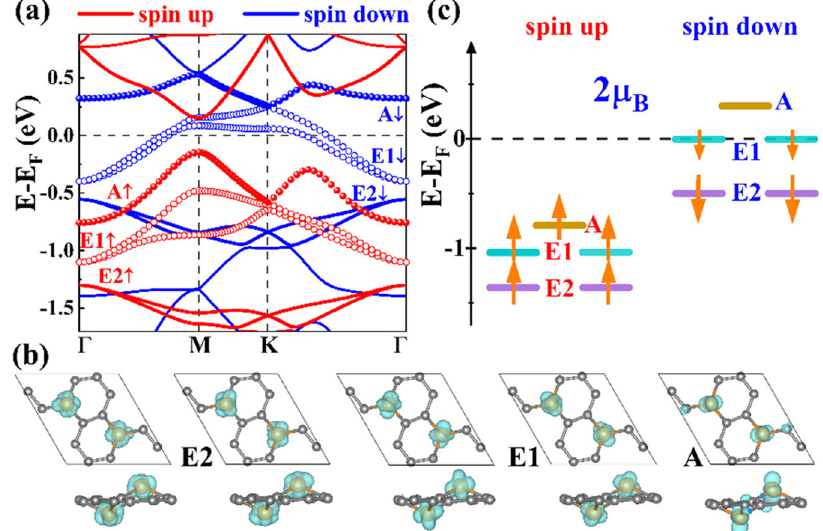
Fig. 4 Electronic structure analyses for 2D-Fe 2 C 12 . a The spin-polarized band structure of 2D-Fe 2 C 12 . Fe bands near Fermi are labeled by their symmetry A, E1, and E2. b Band-decomposed charge density of the largely non-bonding bands at Γ point, which are responsible for the origin of the magnetic moment. c A simple schematic of non-bonding orbitals that represents the largely non-bonding bands A, E1, and E2. Note that the spin-down E1 orbitals are half fi